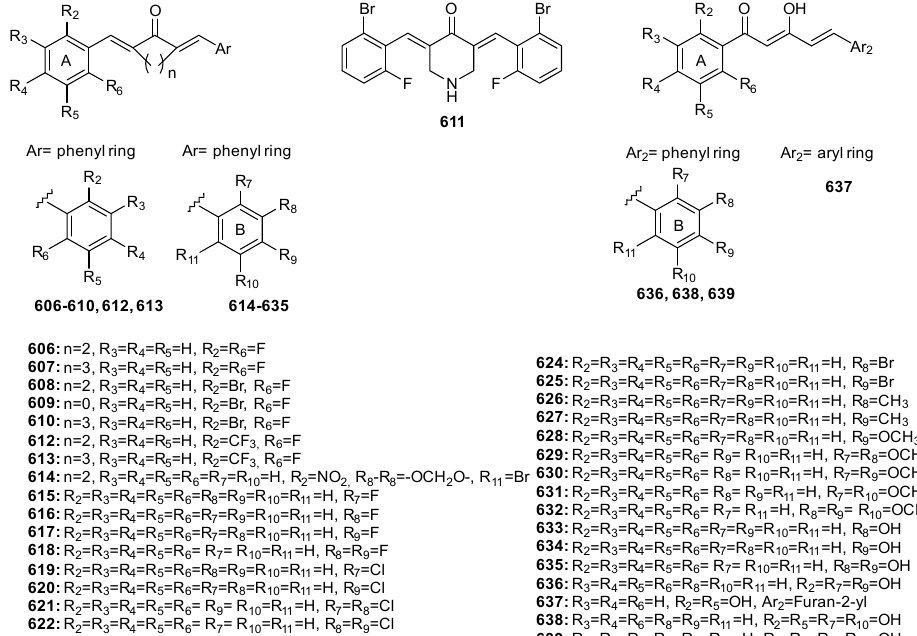
Figure 15. Putative SAR for the antidiabetic activity of diarylpentanoids. 3.5. Anti-hyperuricemic Activity A set of asymmetric diarylpentanoids with cyclohexanone and cyclopentanone moieties ( 640 – 661 : Figure 16) was synthesized and tested for its effectiveness as an anti- hyperuricemic agent by using hyperuricemic mice models induced with oxonate treatment [65]. Generally, compounds exhibited remarkable anti-hyperuricemia activity,